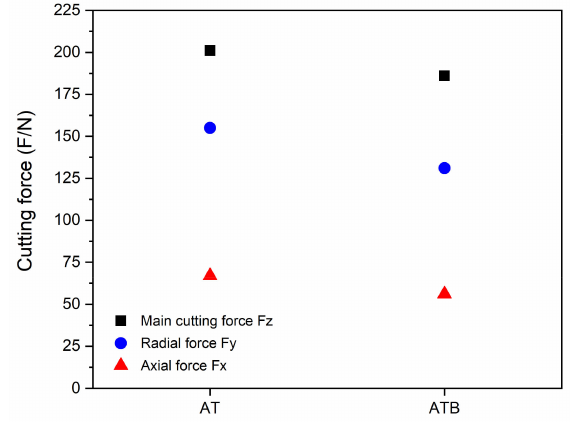
Figure 10. Comparison of cutting forces of different cutting